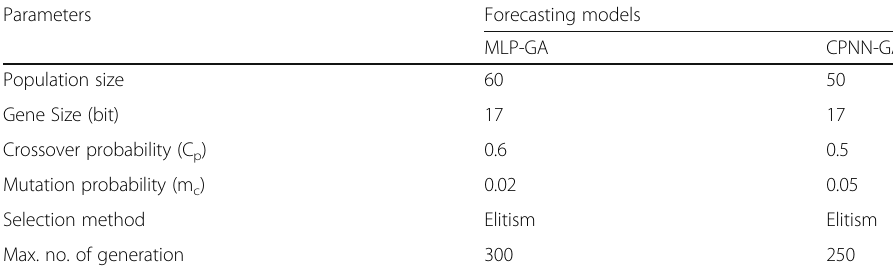
Table 2 Simulation parameters for MLP-GA and CPNN-GA forecasting